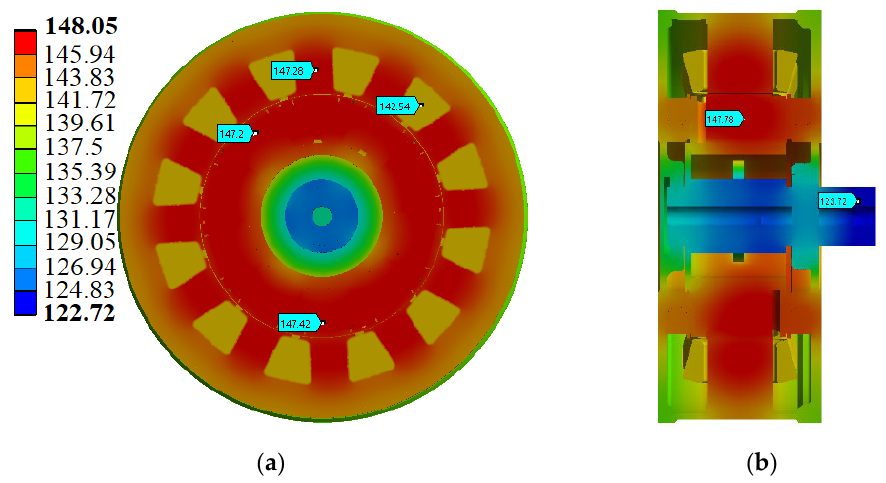
Figure 17. The temperature distribution of different components in DHEG when the ambient tem- perature is 75 °C: ( a ) Front view; ( b ) Section view.